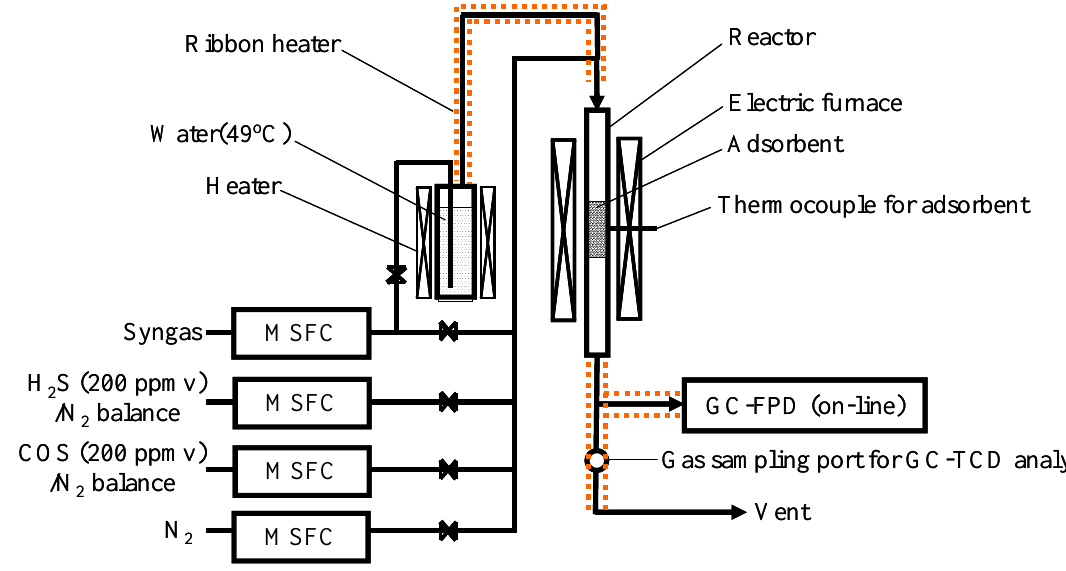
Figure 8. Scheme of the fixed-bed reactor for H